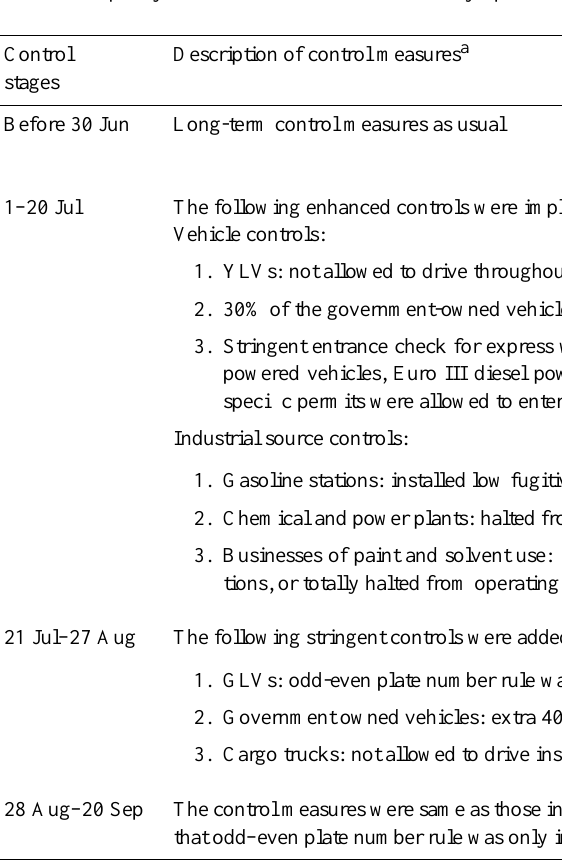
Table 1. Air quality control measures for the 2008